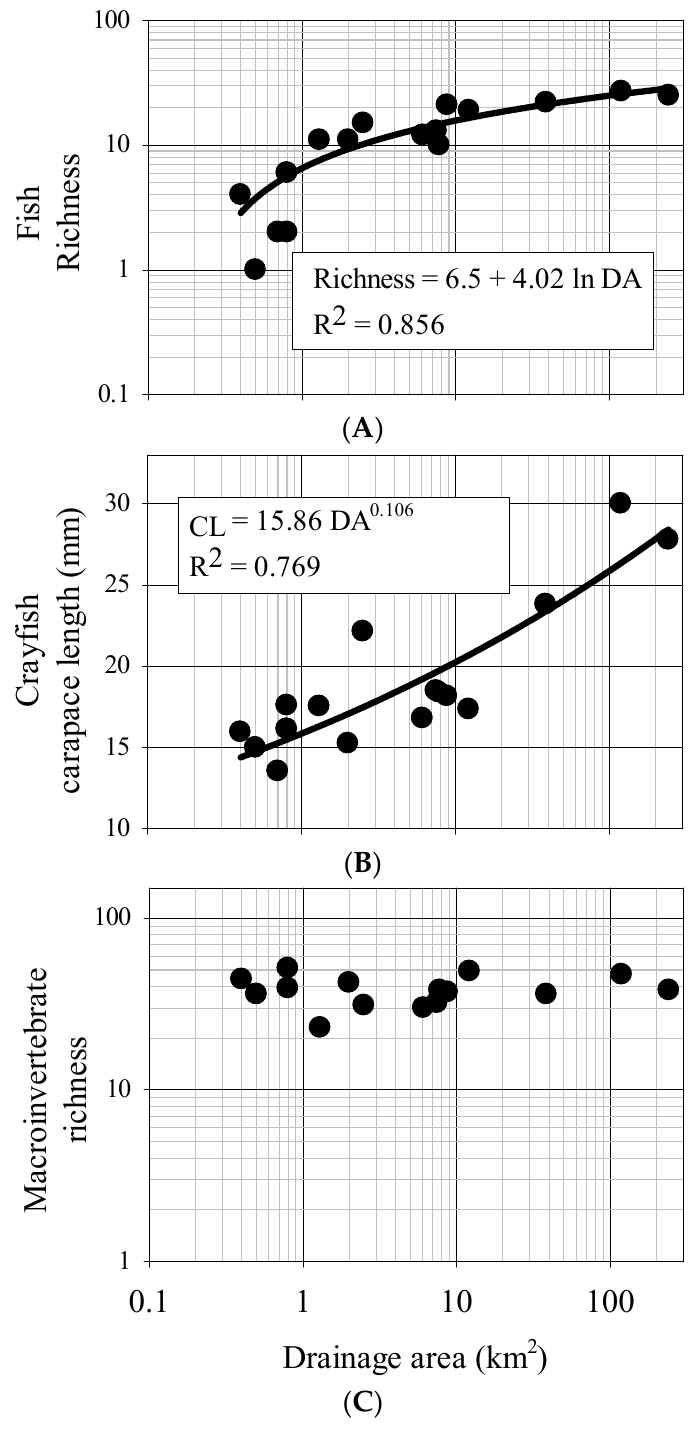
Figure 5. Regional ecological endpoint curves for Alabama Piedmont reference streams. All biotic variables are related to drainage area by either a logarithmic model (fish, y = y o + a ln x) or a power model (crayfish, y = ax b ) where y is the biotic richness and x is the bankfull dimension measure, a is slope and b is model parameter. ( A ) Fish richness, ( B ) crayfish richness, ( C ) bug richness.